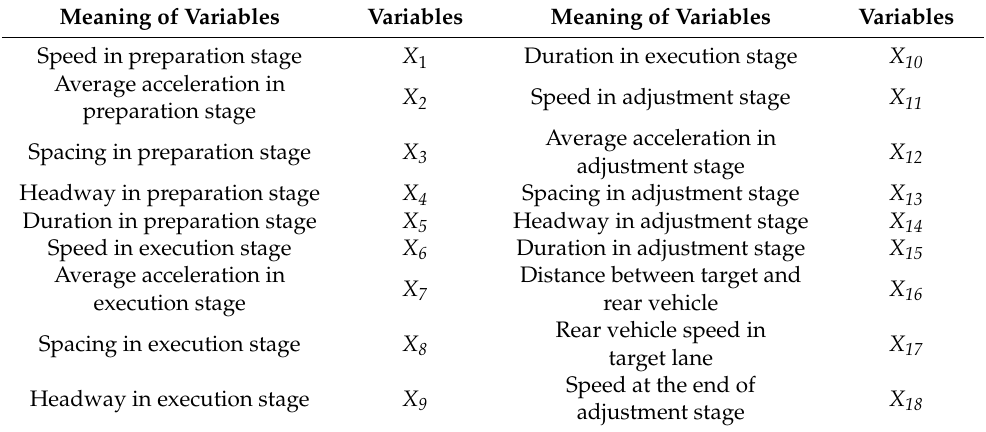
Table 1. Diagram of relevant variables.